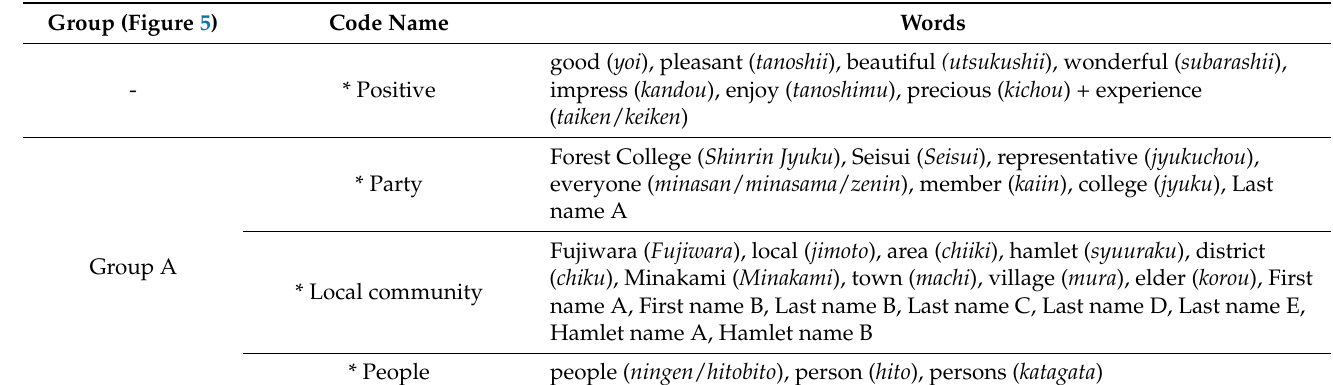
Table 4. Coding rules for dictionary-based